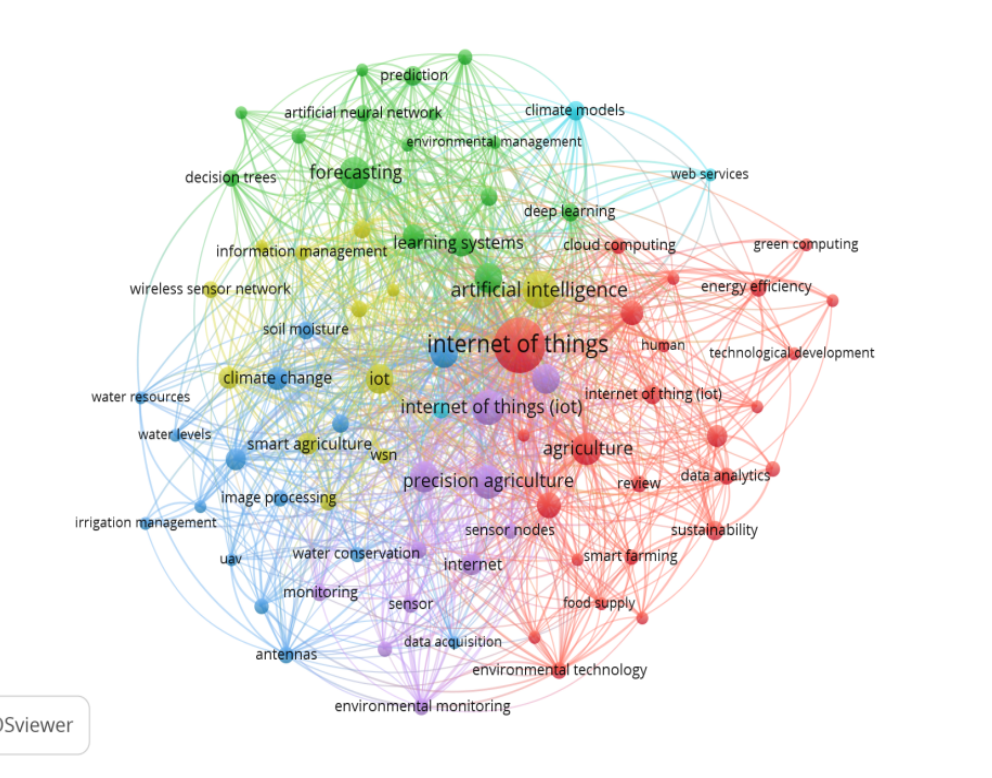
Figure 14. Funding Sponsors statistics for IoT in agriculture. Repository information retrieval source: http://www.scopus.com (accessed on 21 December 2020)).